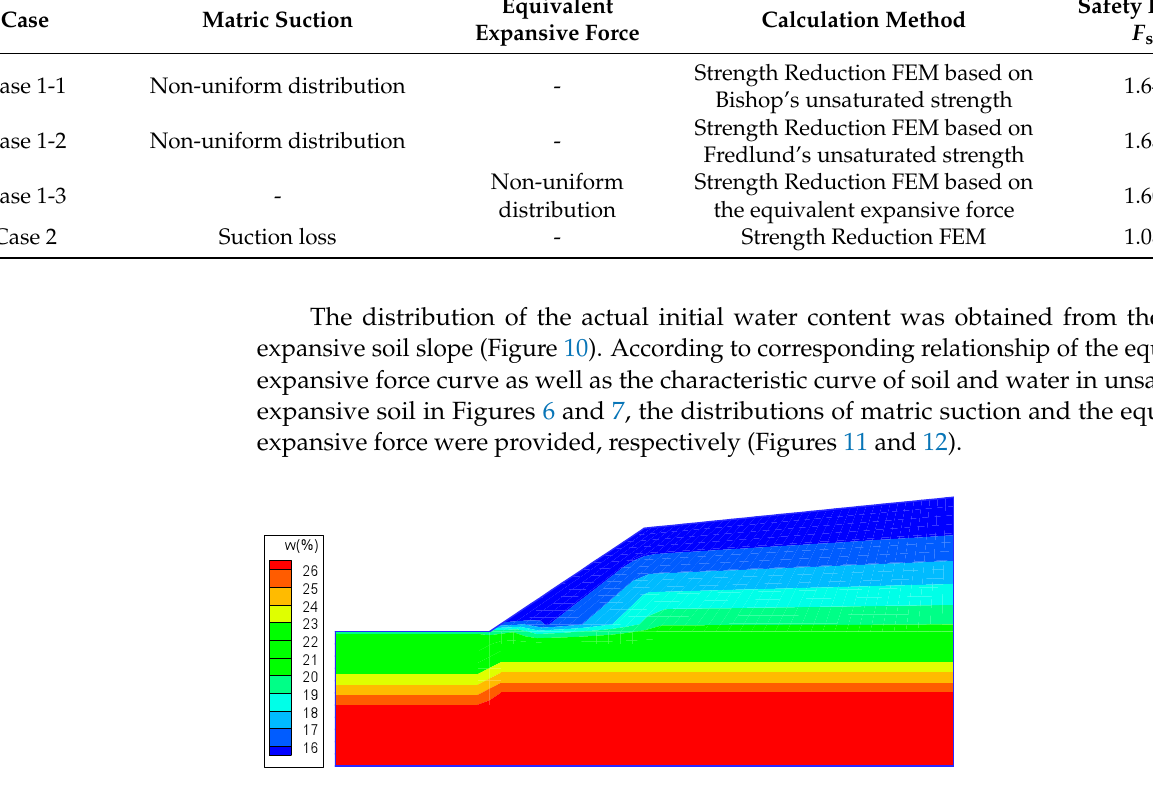
Figure 11. Contours of matric suction (unit: kPa). Figure 12. Contours of the equivalent expansive force (unit: kPa). For the non-uniform distribution of matric suction or the equivalent expansive force, Figure 13a shows the contours of the displacement increment for Case 1-1. The safety fac- tor ( F s = 1.64) was calculated by the strength reduction FEM based on Bishop’s unsaturated strength formula. The displacement increment contours for Case 1-2 are shown in Figure 13b. The safety factor ( F s = 1.63) was calculated by the strength reduction FEM based on Fredlund’s unsaturated strength formula. The contours of the displacement increment for Case 1-3 are illustrated in Figure 13c. The safety factor ( F s = 1.60) was calculated by the strength reduction FEM based on the equivalent expansive force.